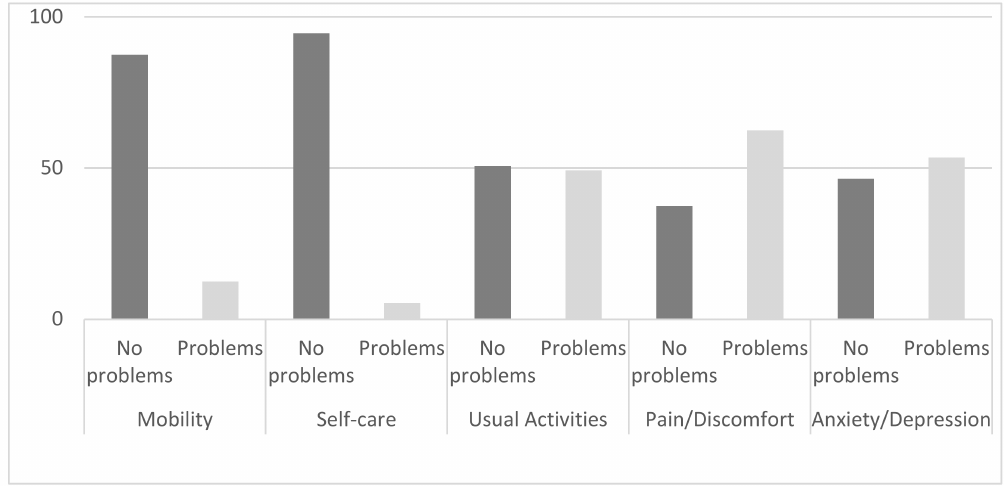
Figure 2. The percentage of reported problems for each dimensions of caregivers QoL. With regards to EQ-5D VAS the patients’ score was statistically lower ( p < 0.001) than caregivers (respectively 65.5 (ES = 2.9) out of 100 for patients versus 74.6% (ES = 2.2) for caregivers) (Table